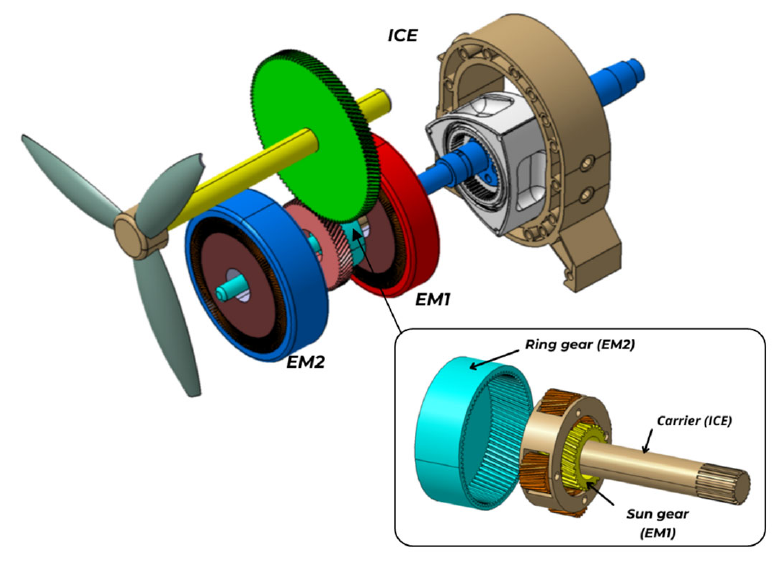
Figure 1. Toyota powersplit adopted in a previous investigation [2].